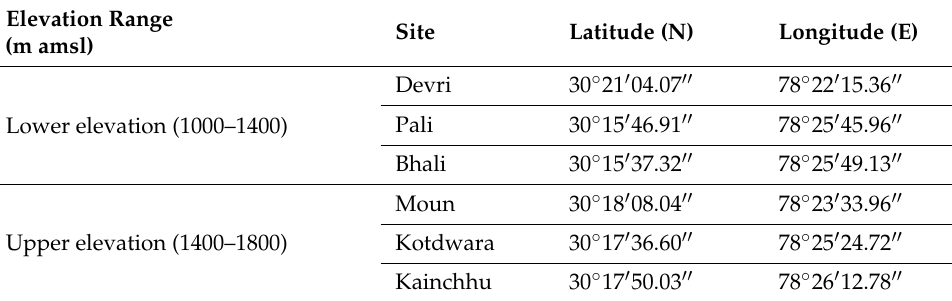
Figure 1. Overview of Grewia oppositifolia -based traditional agroforestry system in Garhwal Himalaya. Table 1. Geographic information (co-ordinates) of study sites.